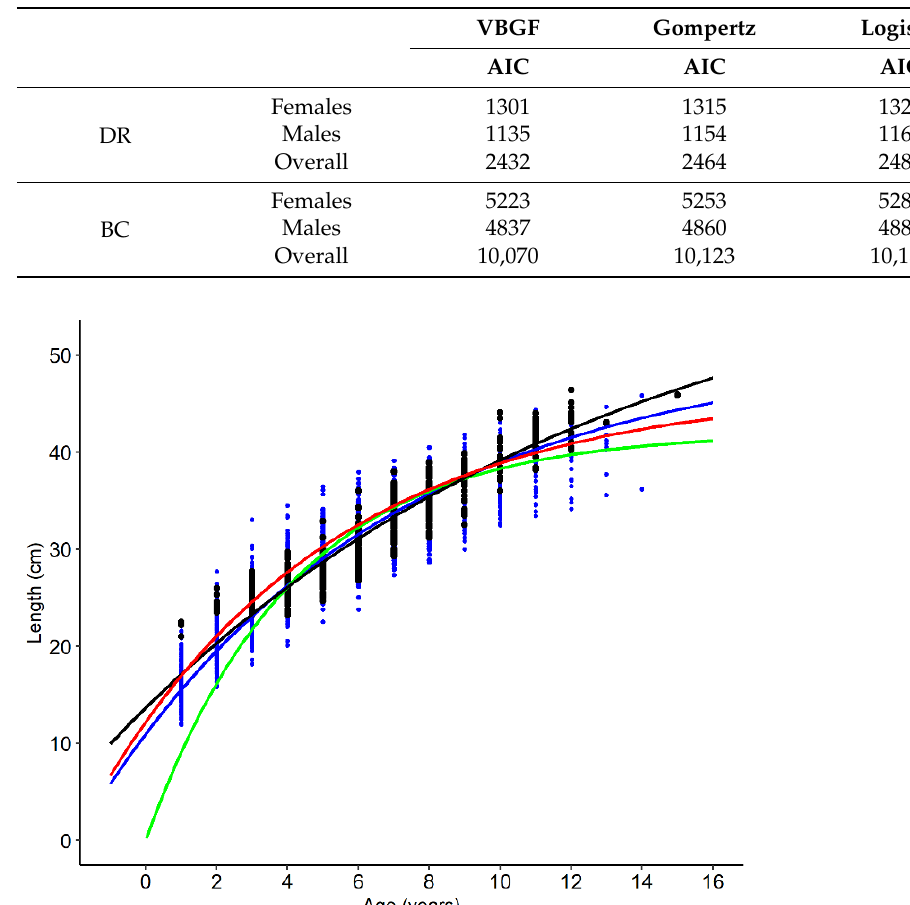
Figure 1. Comparison between the von Bertalanffy growth function estimated by the four approaches applied to length-at-age of Trachurus picturatus from Portuguese continental coast. Black dots are direct readings and blue dots are back-calculated lengths-at-age. Black line—direct readings (DR); green line—direct readings with t 0 = 0 (DRfix); red line—back-calculation (BC); blue line—Bayesian inference (DRBayes).